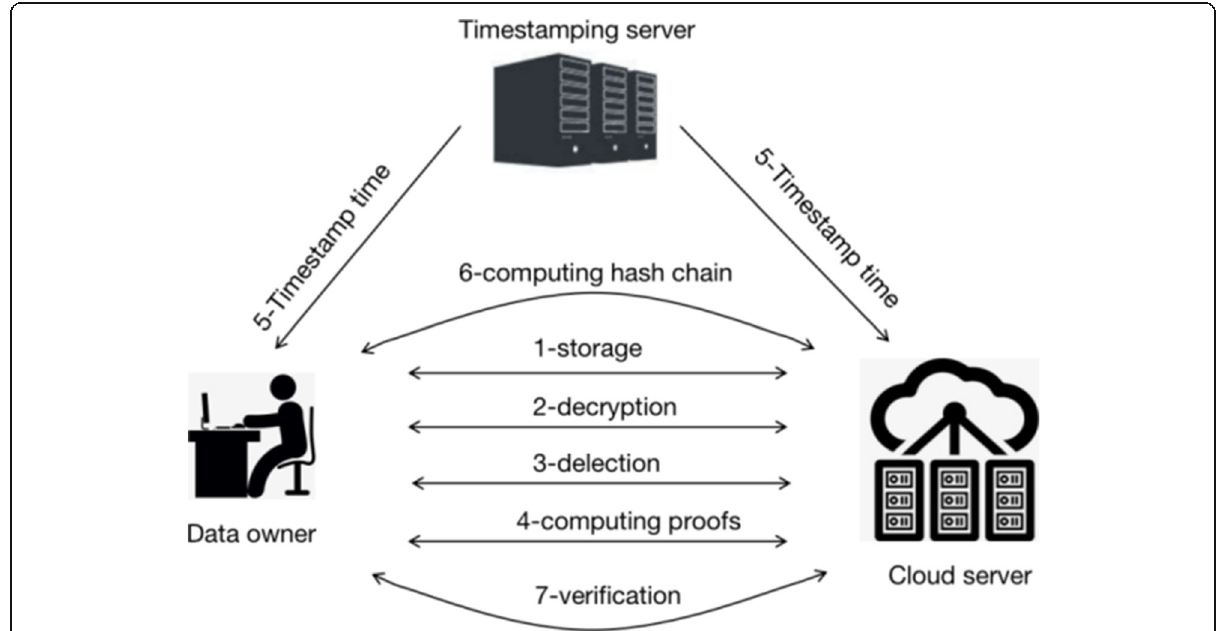
Fig. 20 Basic steps in data deletion